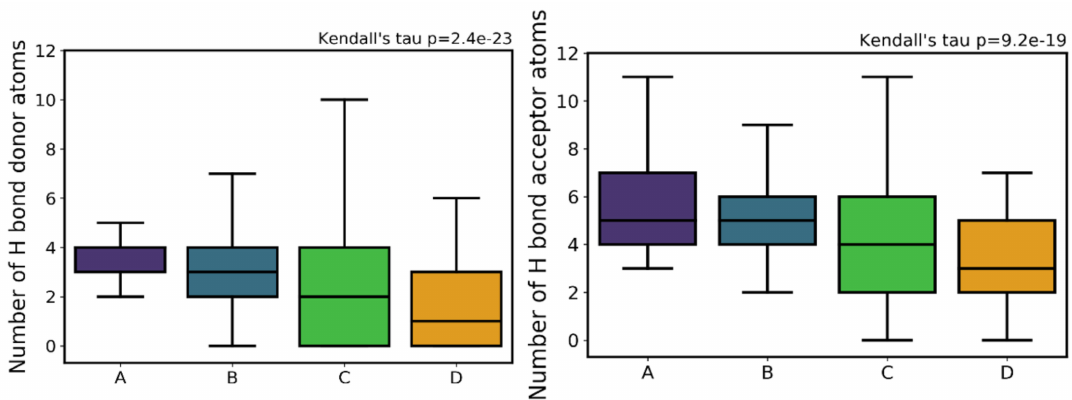
Figure 10. Distribution of hydrogen bond donor (HBD) atoms (left) and hydrogen bond acceptor (HBA) atoms (right) across the di ff erent activity